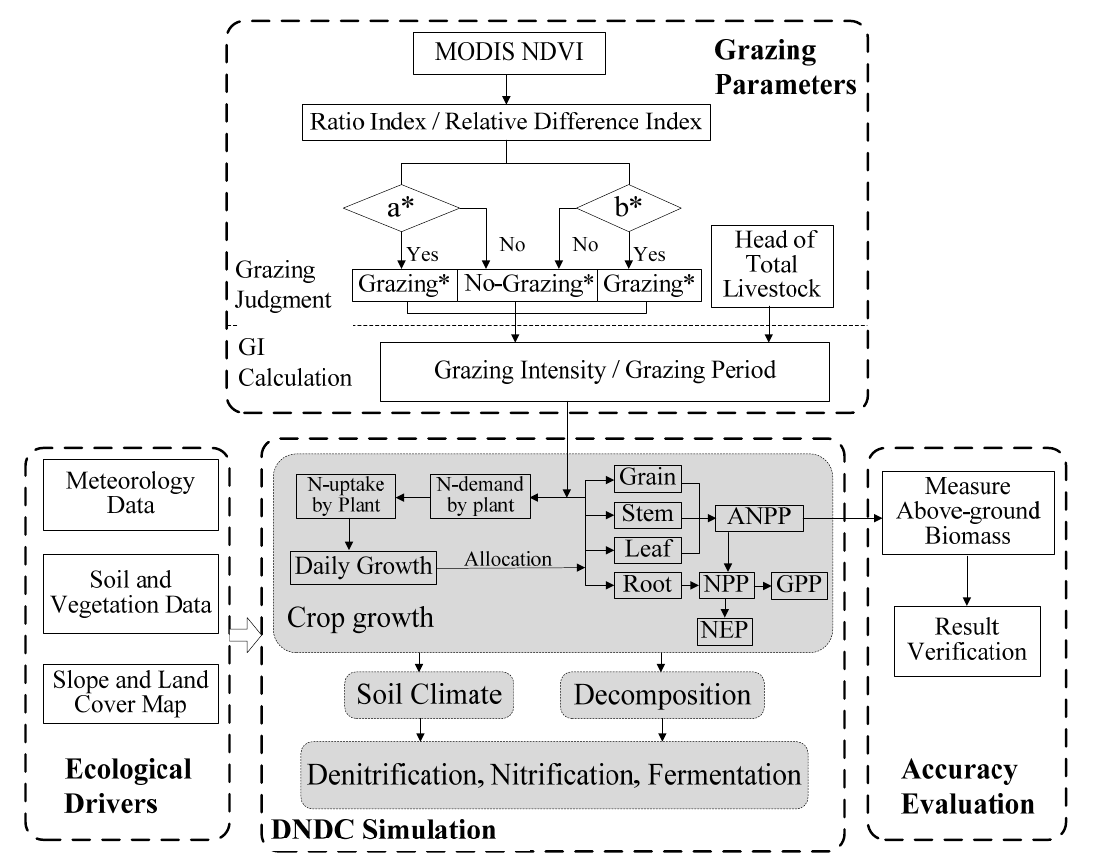
Figure 2. The framework for simulating the grassland ANPP under grazing condition for each simulation site with the DNDC model. a* and b* are conditions to judge whether a pixel where to be used for grazing; and Grazing* indicates that the pixel is used for grazing, while No-Grazing* implies that the pixel is identified as an non-grazing area.